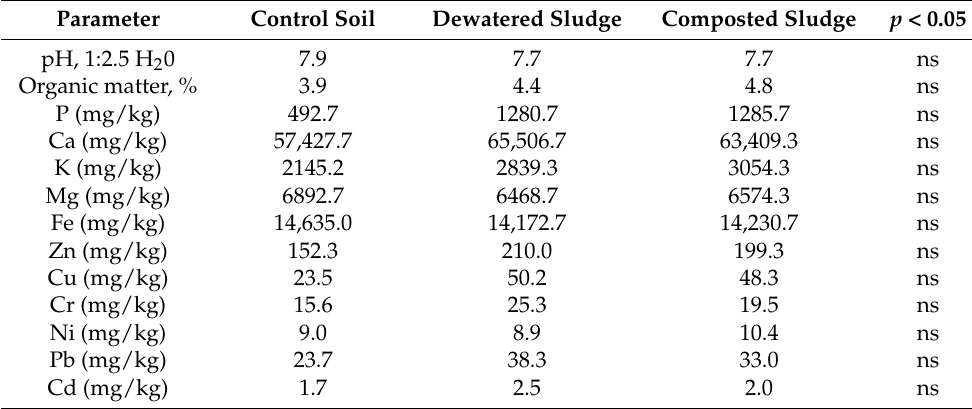
Table 4. Soil parameters at the end of the fertilization with dewatered sludge, composted sludge, and the control without fertilization (dry weight). Parameter Control Soil Dewatered Sludge Composted Sludge p <